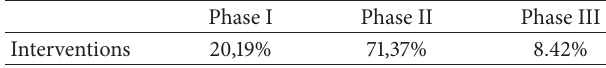
Table 1: Chat intervention percentage in each phase. Table 2: Number and percentage of students that passed each part of the exam.